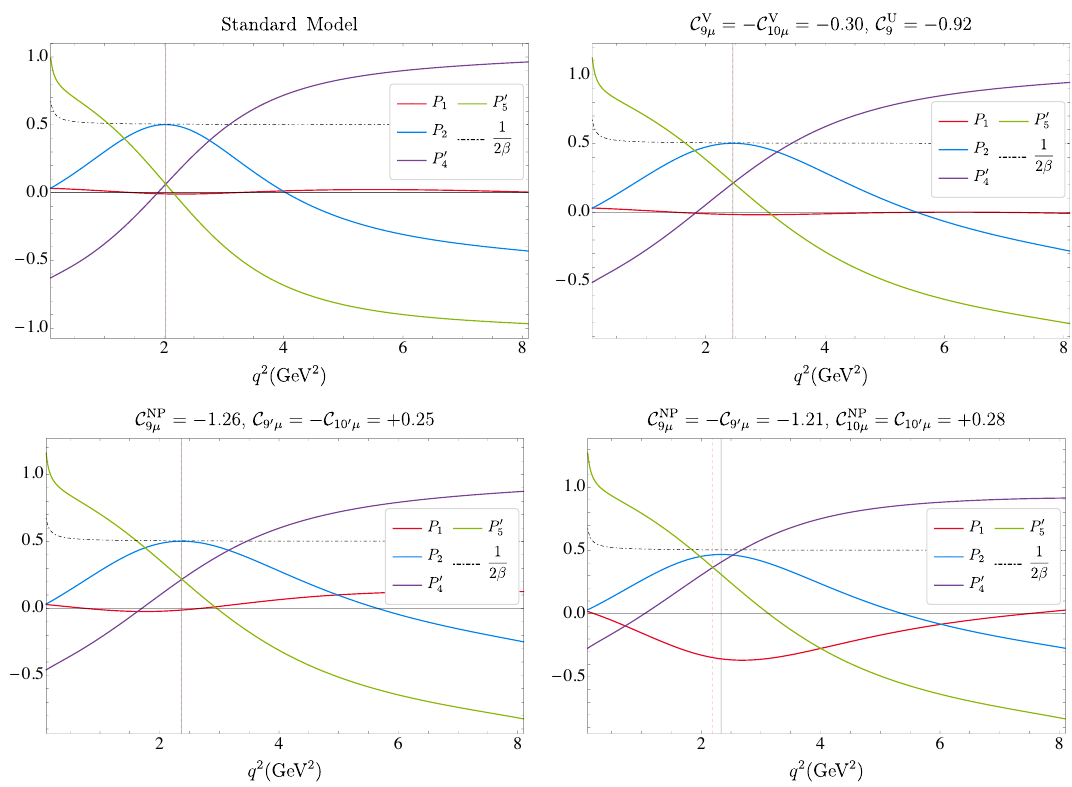
Figure 6 . Predictions for different P i observables in (top left) the SM, (top right) Scenario 8, (bottom left) Hypothesis 5 and (bottom right) Hypothesis